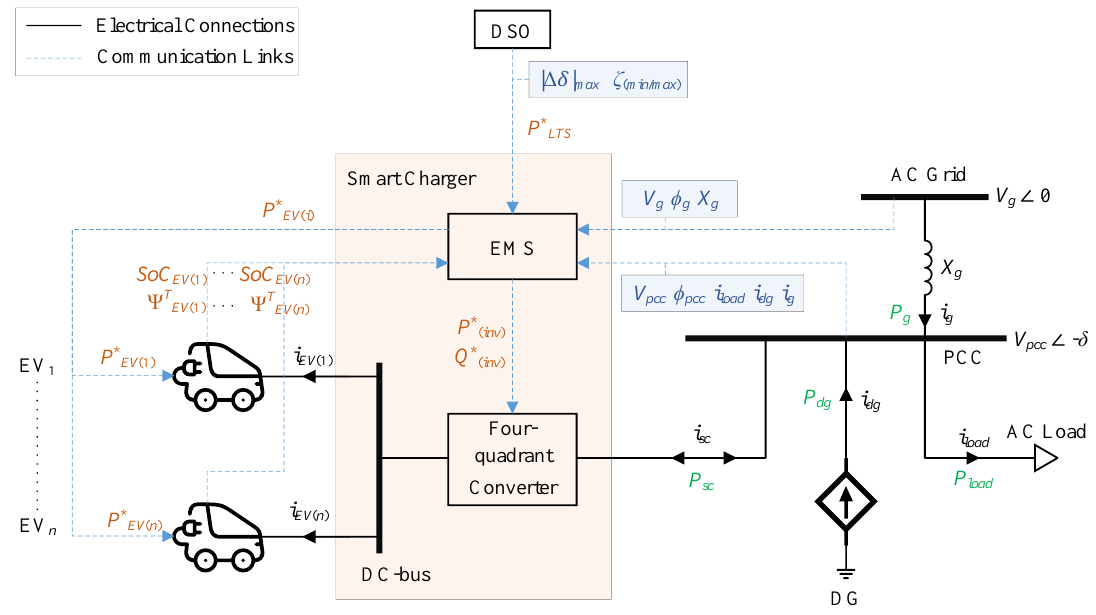
Figure 10. Energy management scheme (EMS) control functioning within the smart charger